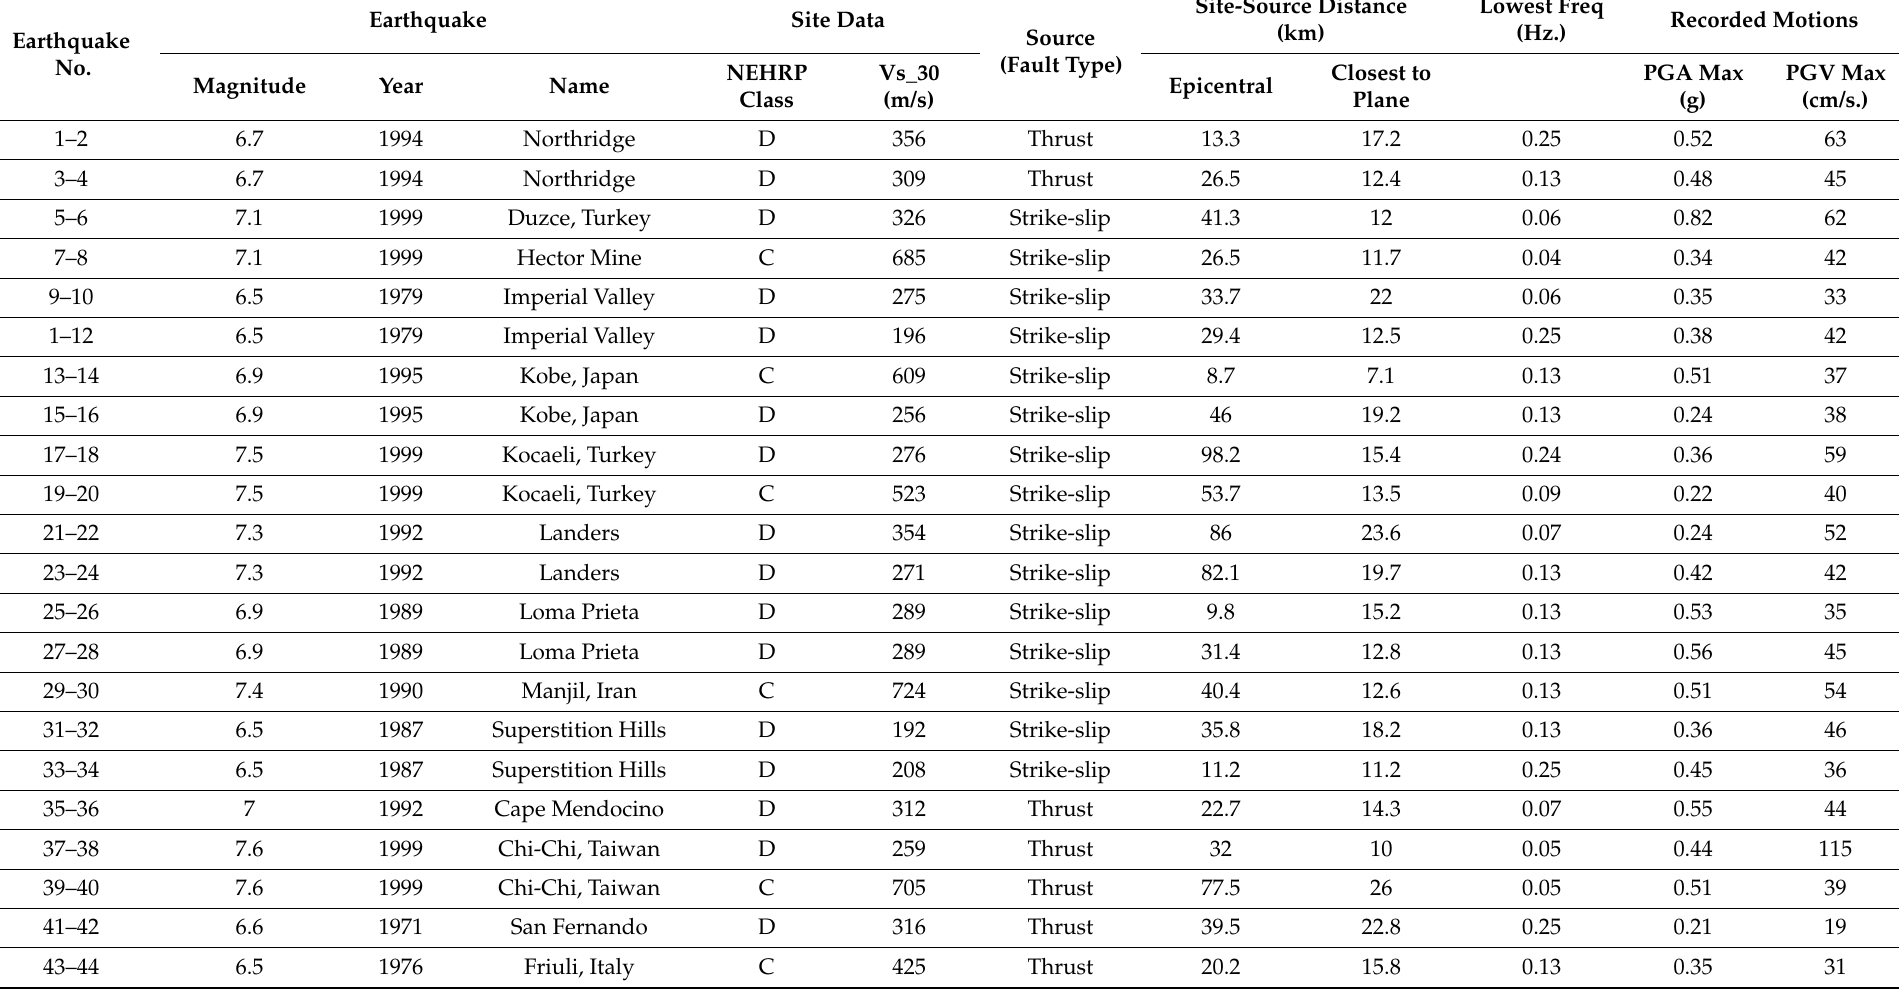
Table 3. FEMA P-695 far-field ground motion